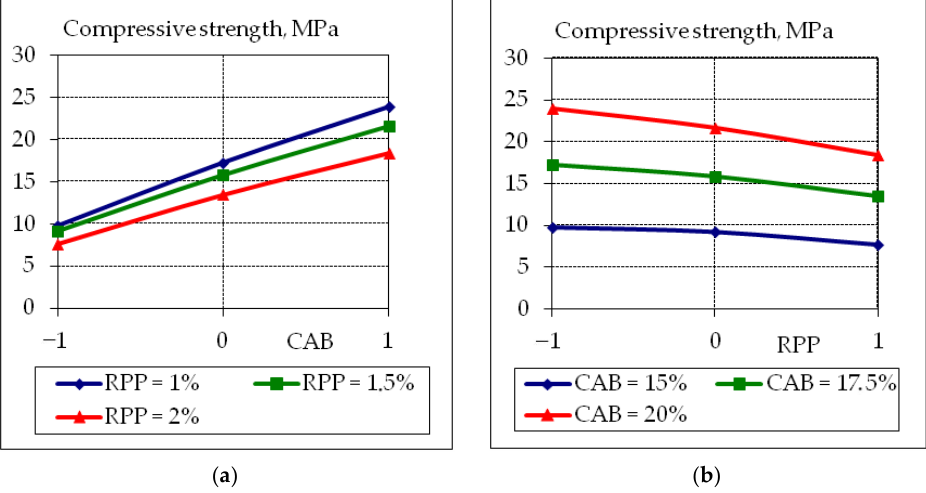
Figure 10. Graphical dependences of compressive strength at the age of 28 days of fly ash concrete suitable for 3D printer, where the content of CAB ( a ) −1 = 15%; 0 = 17.5%; +1 = 20%, and RPP ( b ) −1 = 1.0%; 0 = 1.5%; +1 = 2.0%.